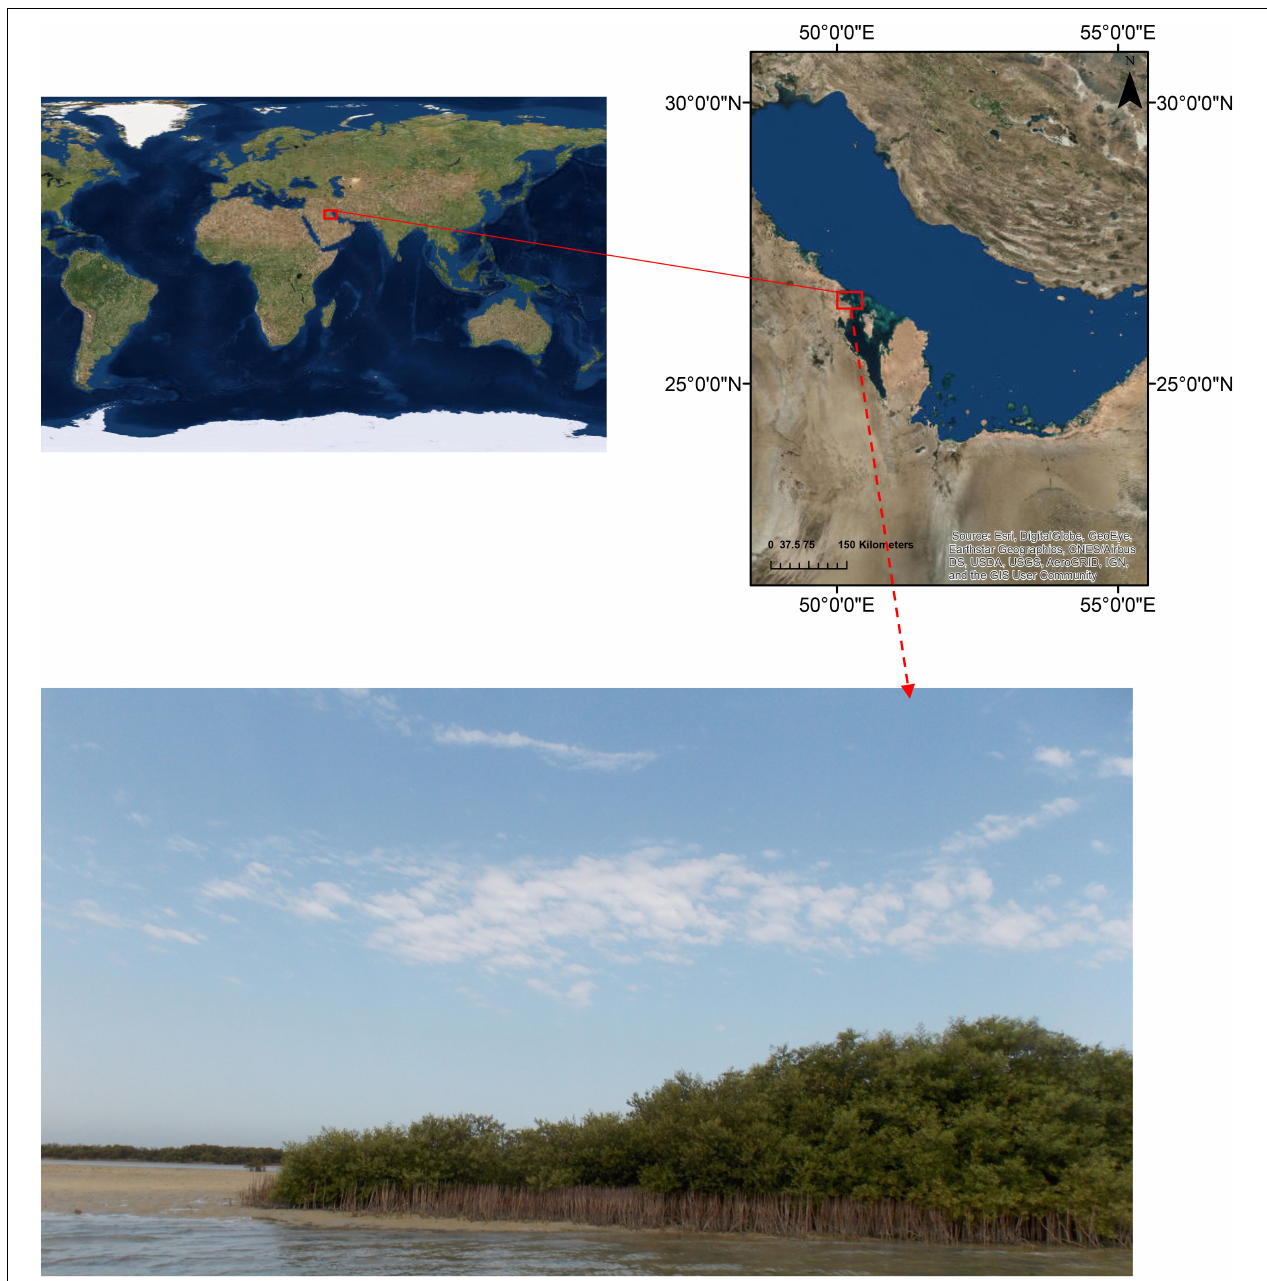
FIGURE 1 | Location of mangrove sampled area in Syhat city, Saudi Arabia, Western Arabian Gulf. Both mangrove photograph and map were produced by the researcher. The map was produced using ArcMap Version 10.2. Source: Esri, DigitalGlobe, GeoEye, Earthstar Geographics, CNES/Airbus DS, USDA, USGS, AeroGRID, IGN, and the GIS User Community (https://www.arcgis.com/home/item.html?id~=~ab399b847323487dba26809bf11ea91a).